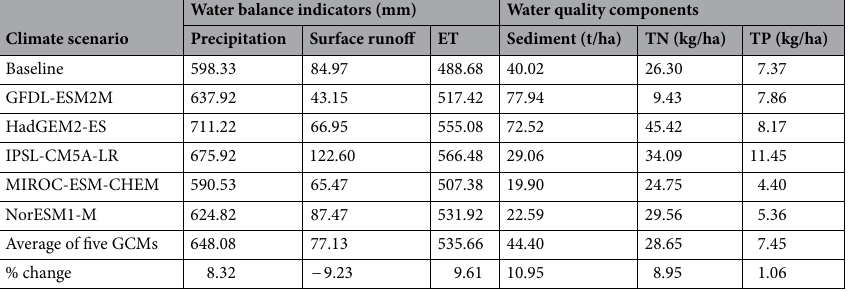
Table 2. Comparison of average annual hydrology and water quality components in the TMC among baseline scenario (1980–2004) and future climate scenarios throughout 2020–2099 obtained from five GCMs driven by RCP